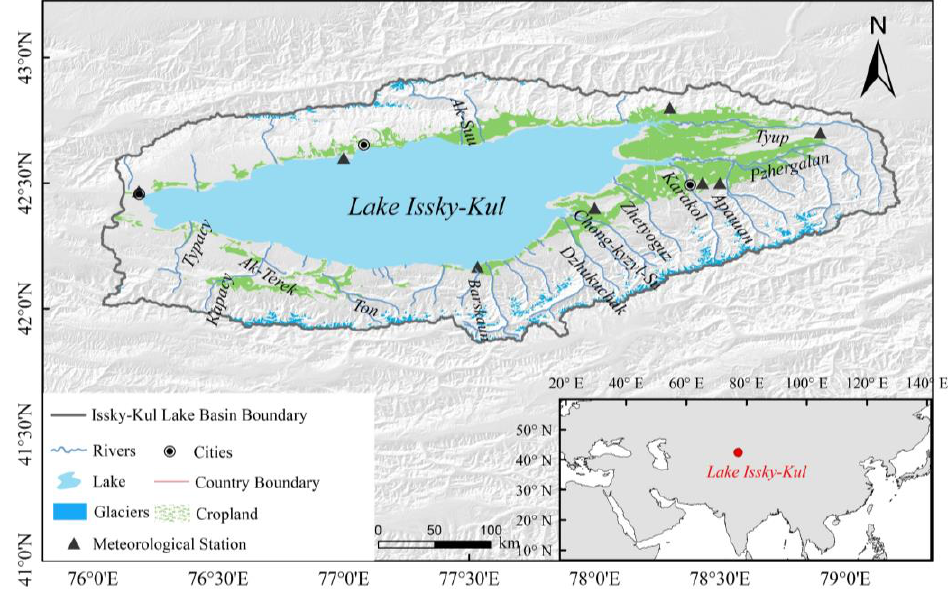
Figure 1. Location map of Lake Issyk-Kul. Glaciers’ shapes were derived from the Randolph Glacier Inventory (RGI) 6.0. The cropland data were derived from the Globalland30 dataset.